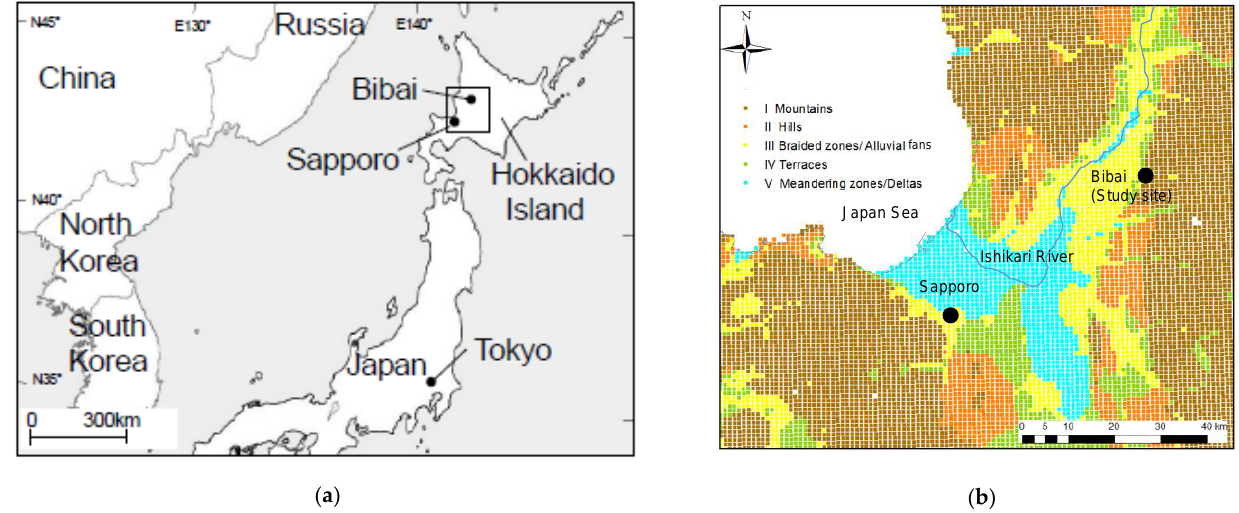
Figure 1. Site location ( a ) and upscaled topographic ( b ) maps.